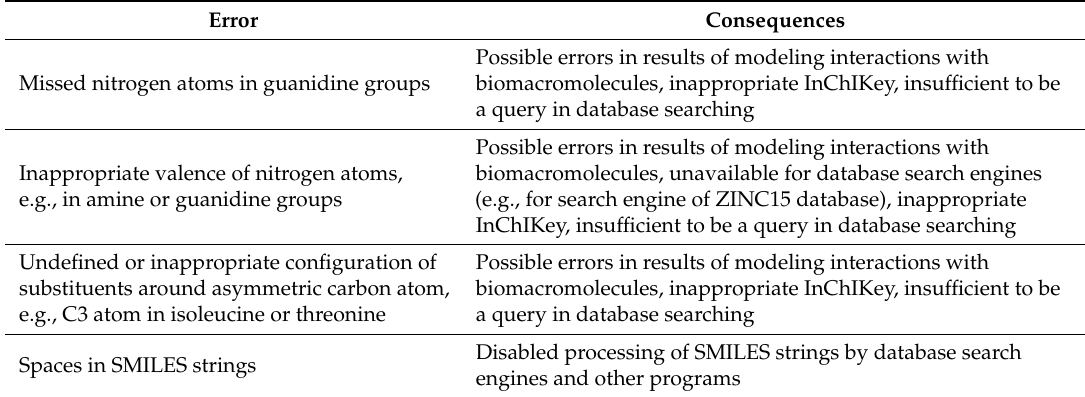
Table 1. Possible errors in SMILES strings of peptides and their